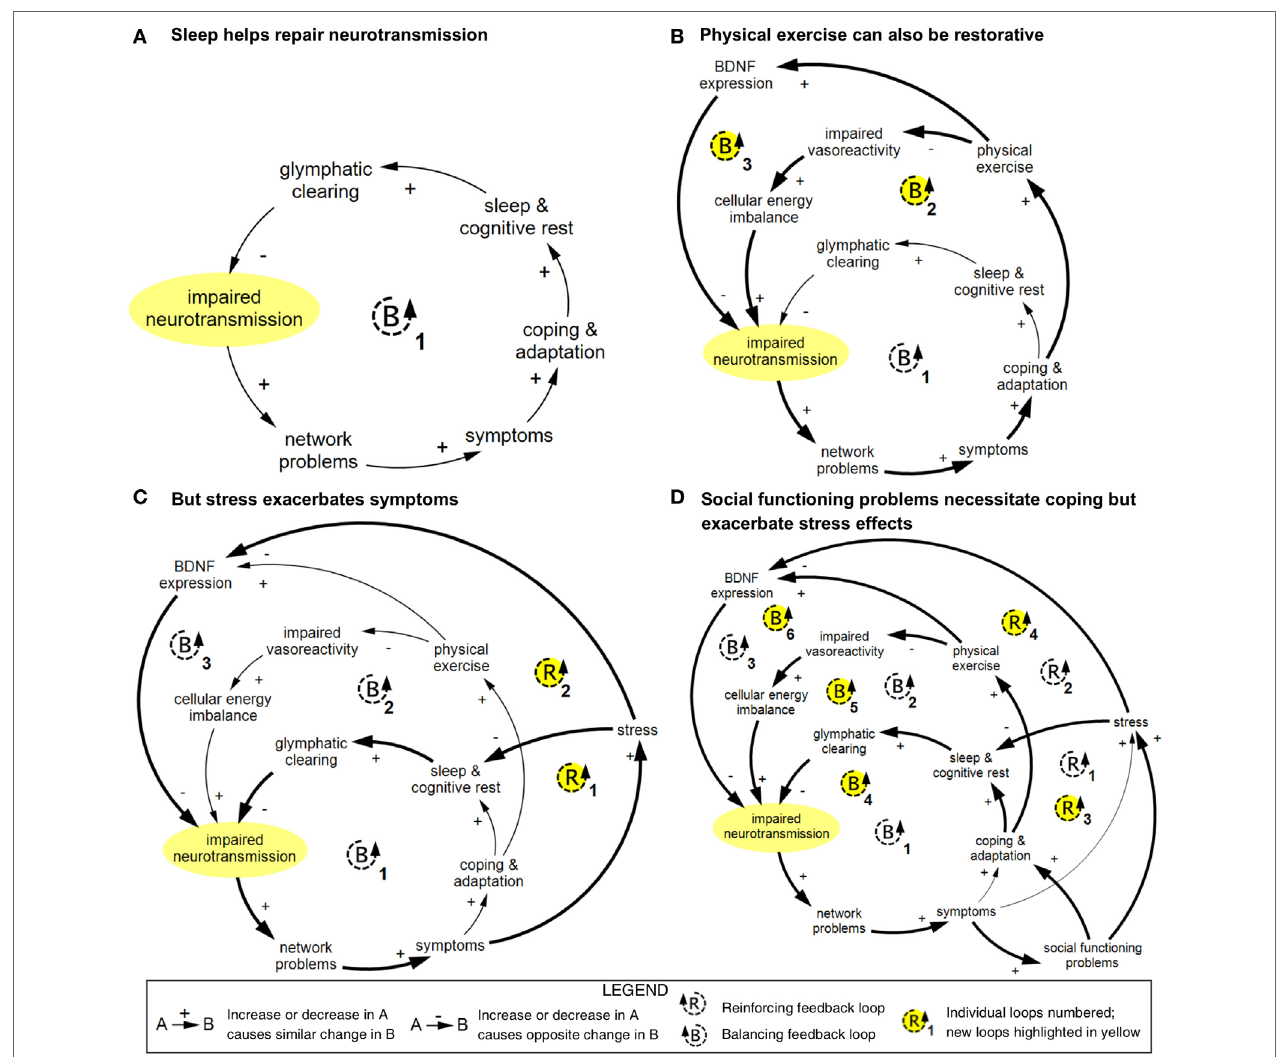
FigUre 8 | Simplified cross-scale feedback loops pertaining to impaired neurotransmission. These diagrams depict abbreviated versions of feedback loops described in Figure 1 and demonstrate how connected loops can have compounding and counteractive effects. (a) In loop B1, impaired neurotransmission affects the function of networks; these networks and network functions include limbic, intrinsic connectivity networks, attentional filtering, and processing speed. Disruption in these networks results in a range of symptoms included in Figure 1 (specifically, light or sound sensitivity, impairment in emotional regulation, impulsivity, irritability/mood instability, stress, depression/anxiety/mood disorders, reduced social functioning, impaired working memory and executive function, reduced cognitive load capacity, dizziness and vertigo, balance and gait problems, impaired prediction of sensory input, visual/perceptual impairment, disorientation and confusion, and reduced ability to work and complete daily tasks). Either directly or indirectly, these symptoms prompt coping and adaptation strategies, including avoidance of overstimulation, pursuit of and adherence to treatment, cognitive rest, and addressing of sleep problems. Restorative sleep processes lead to glymphatic clearing of brain waste and energy byproducts, which in turn results in improved neurotransmission via an improved cellular milieu and support of neuroplasticity. (B) In loop B2, physical exercise is used as a coping and adaptation strategy, which improves vasoreactivity and cellular energy imbalance, which supports neurotransmission. In loop B3, brain-derived neutrophic factor (BDNF) expression is strengthened, which reduces impaired neurotransmission via improved neuroplasticity. (c) Stress can disrupt sleep and inhibit BDNF expression, which creates two reinforcing loops. (D) Social functioning problems can prompt coping and adaptation, which introduces three additional balancing loops, and increase stress, which compounds the reinforcing effects of stress. Diagrams rendered in